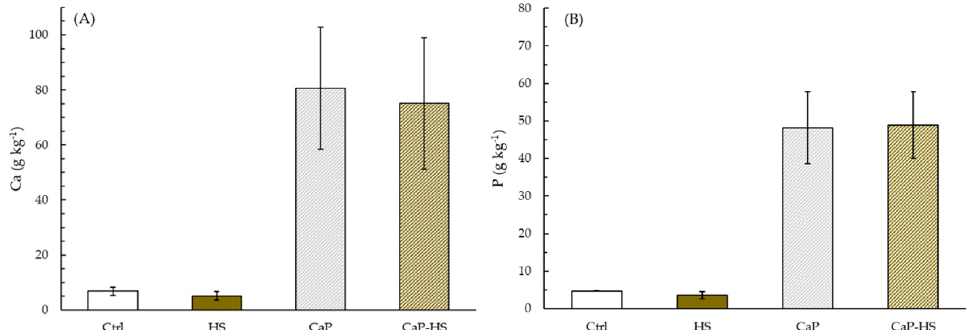
Figure 5. Concentration of Ca ( A ) and P ( B ) in root of Diplotaxis tenuifolia . Data are mean ± standard deviation (n = 4). When the interaction between experimental factors (CaP × HS) was significant at ANOVA, different letters were used to indicate statistically significant differences between treatments at Tukey’s post-hoc test ( p ≤ 0.05).